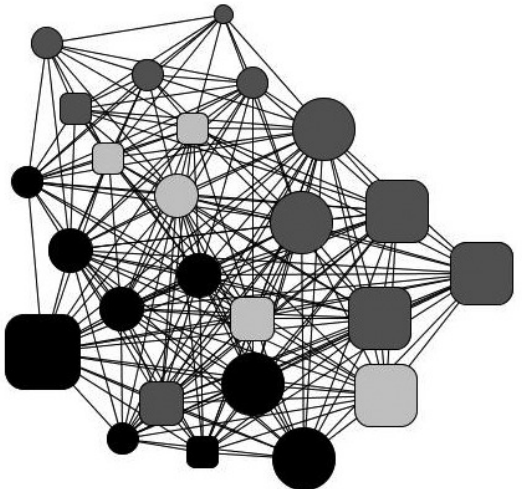
Figure 3. Laura’s personal network. Notes: Node size indicates relational role—size 1 (biggest; closest family: parents, broth‐ ers/sisters, and sons/daughters), size 2 (in‐laws), size 3 (friends, neighbours), size 4 (distant relatives), size 5 (smallest; social worker, “others”); node shape indicates gender—circle (female), rounded‐square (male); node colour indicates proximity: black (“very close”), dark grey (“close”), light grey (“not very close”), white (“not close at